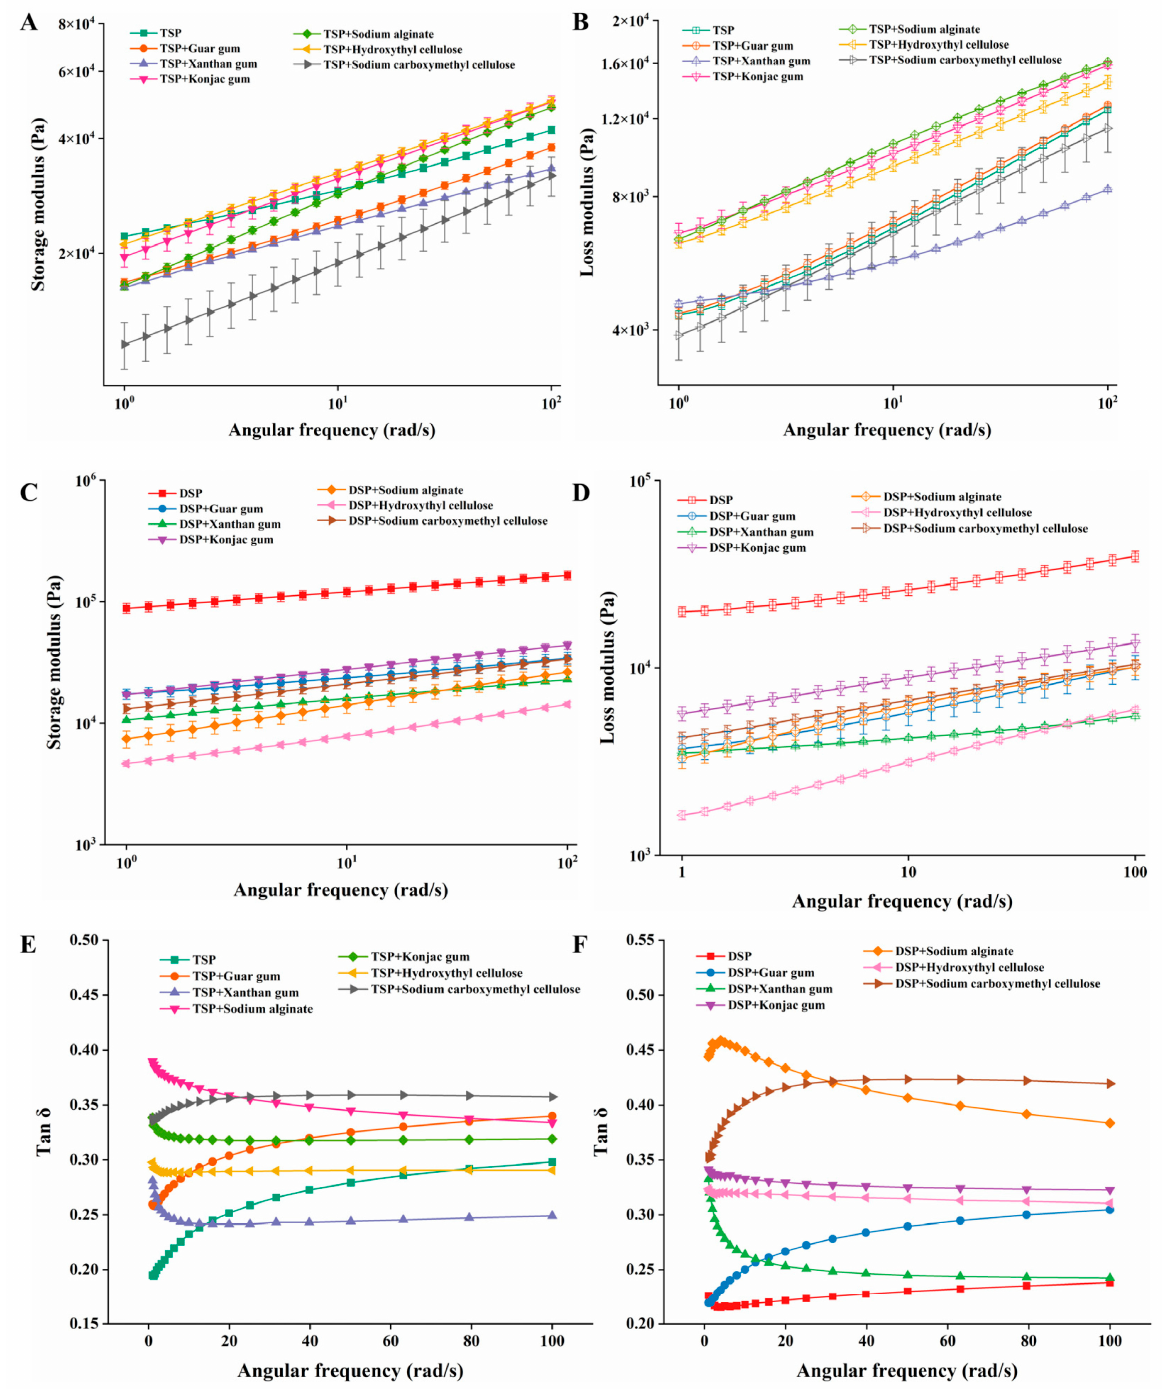
Figure 2. The rheological properties of different inks. ( A , C ) G ′ of composite TSP and DSP inks added with different hydrocolloids. ( B , D ) G ″ of composite TSP and DSP inks added with different hydrocolloids. ( E , F ) Tan δ of composite TSP and DSP inks added with different hydrocolloids.